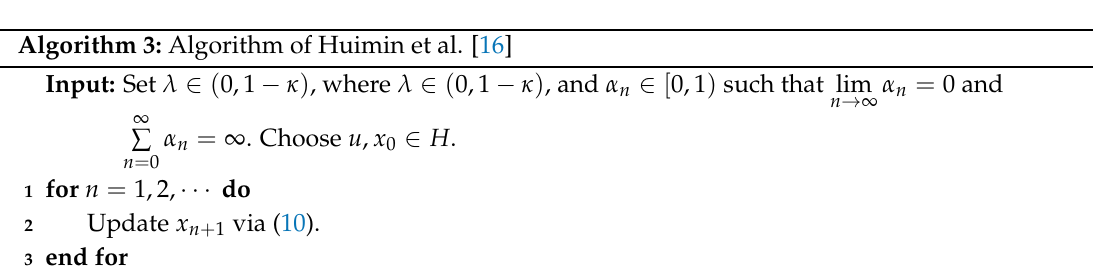
Algorithm 3: Algorithm of Huimin et al.